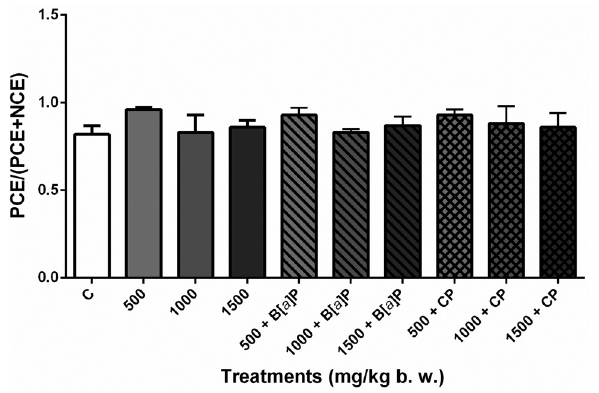
Figure 2 - Evaluation of cytotoxicity in mouse bone marrow cells after acute treatment with S. dulcis bark ethanolic extract (500, 1000, and 1500 mg/kg bw) associated or not with B[ a ]P and CP. Calculation of PCE/(PCE+NCE) on examination of 1000 erythrocytes. Shown are means (cid:2) SD for 10 animals (male and female) from each treatment. ANOVA and Dunnett’s test ( p <0.05). PCE: polychromatic erythrocyte; NCE: normo- chromatic erythrocyte; C: distilled water; B[ a ]P: benzo[ a ]pyrene; CP: cyclophosphamide.